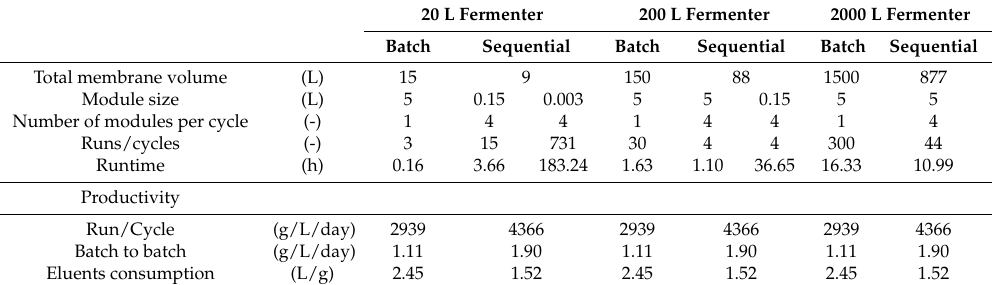
Table 2. Process parameters and results for the 20 L, 200 L, and 2000 L fermenter case